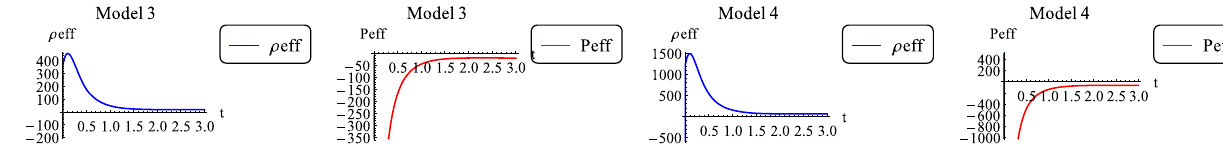
Fig. 5 The energy density, ρ ef f , and pressure, p ef f , in terms of cosmic-time under different viable models